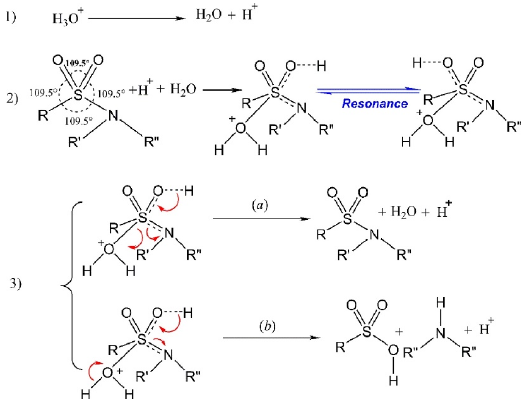
Figure 1. Acidification mechanism of the polyamide separation layer [73].